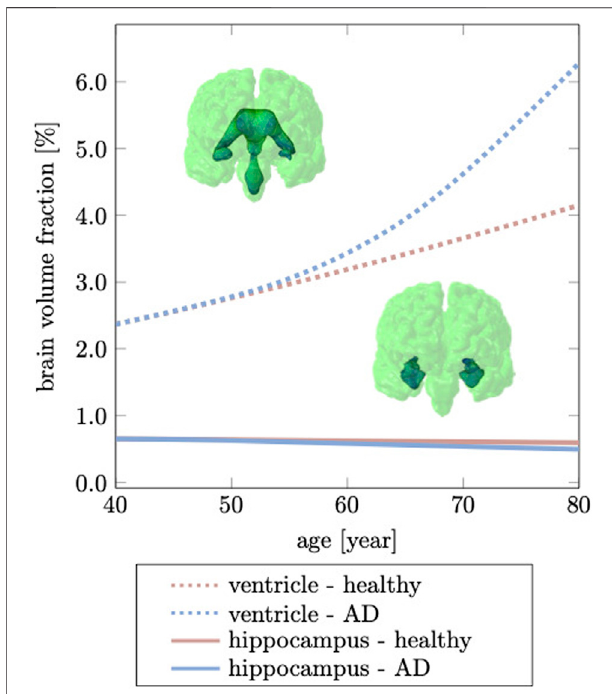
FIGURE9| Hippocampalshrinkingandventricularenlargementdifferfor healthy aging and Alzheimer ’ s disease. The initial overlap between healthy aging and Alzheimer ’ s disease is due to the gradual spread of our biomarker throughthebrainwhichultimately accelerates brainchangespassedthe age of 60 years. This deviation from the healthy trajectory is used as a biomarker for detecting Alzheimer ’ s disease (Apostolova et al., 2012).